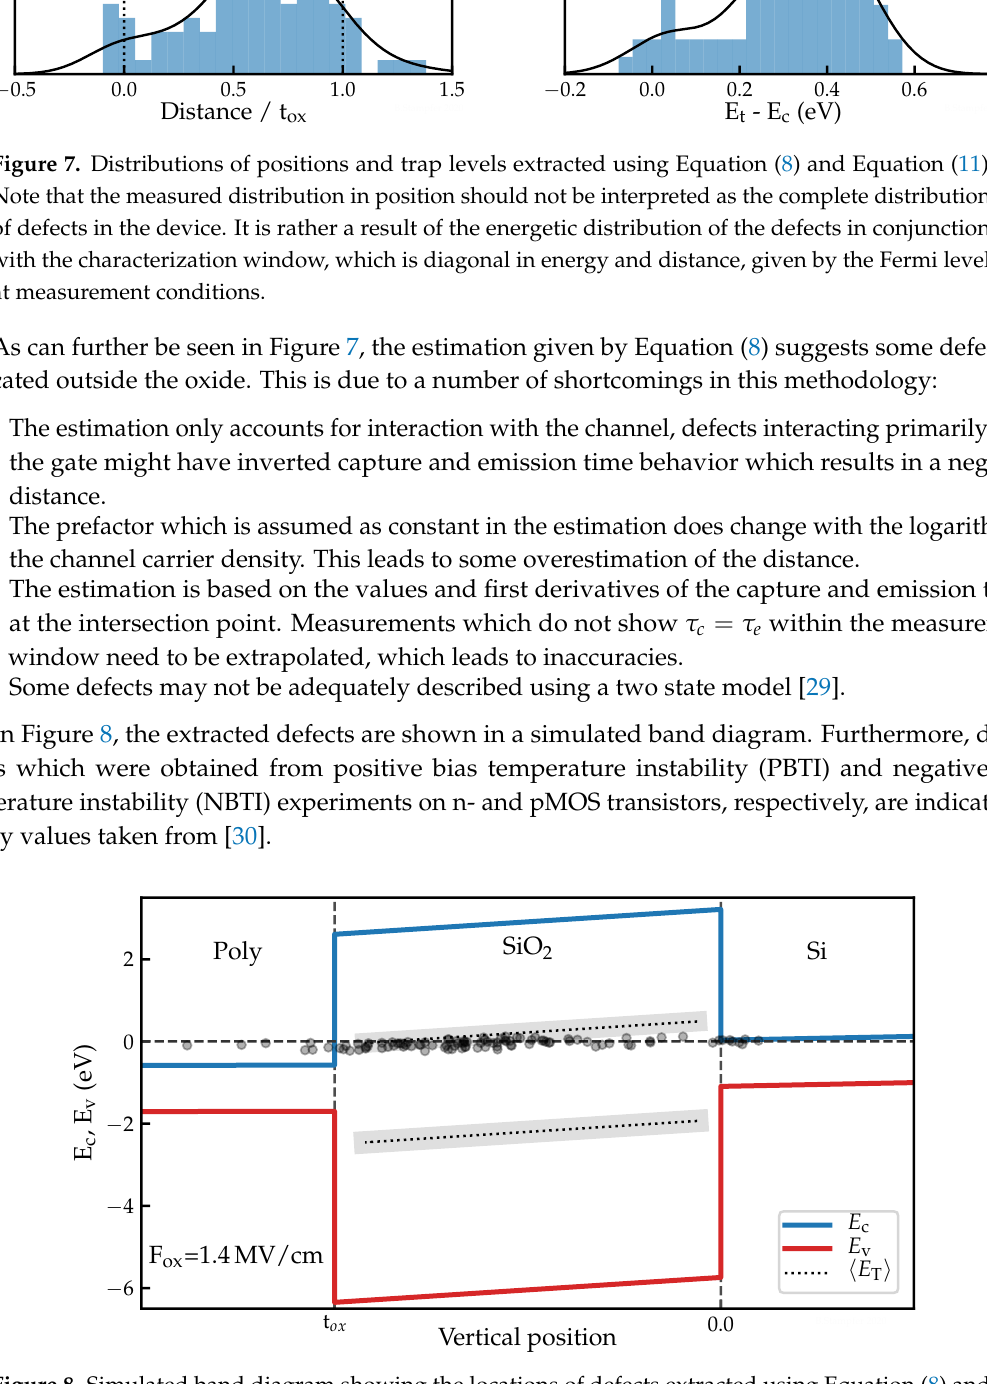
Figure 8. Simulated band diagram showing the locations of defects extracted using Equation (8) and Equation (11). In addition, defect bands as given in [30] are shown in comparison. Notice how some defects appear located outside of the SiO 2 layer. This shows the shortcomings of the estimation used. The estimation does not account for defect interaction with the gate, which often results in negative d / t ox and it generally overestimates the distance of the defects due to the neglected